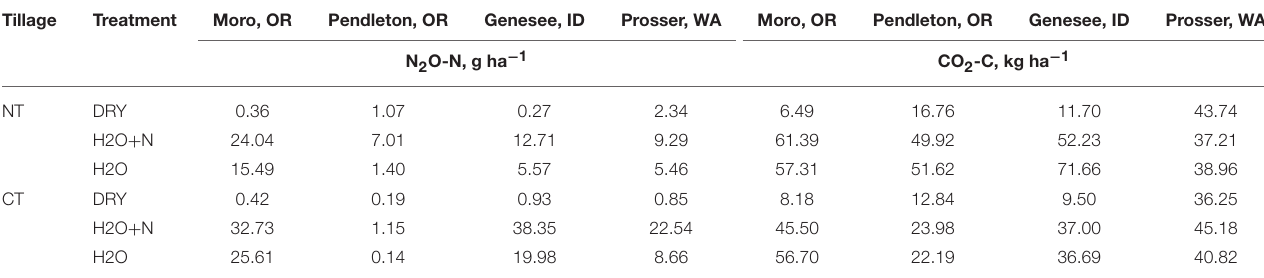
TABLE 3 | Summary table for cumulative emissions of N 2 O and CO 2 during the first day (0–22h) of measurements with and without additions of 150kg N ha − 1 and water to no-tillage and conventional tillage management systems.